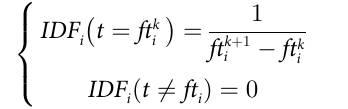
in seconds up to a dataset-specific level of maximum voluntary contraction tr i